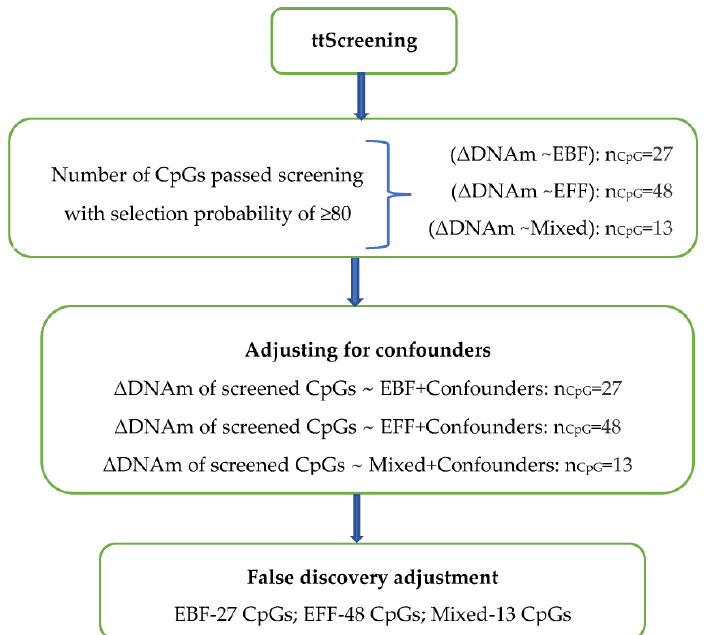
Figure 2. Number of CpGs associated with each infant feeding variable at each stage of analysis. ttScreening—training-testing screening method, ΔDNAm—delta DNA methylation (calculated using M-values) that represents change in DNA methylation from birth to 10 years after adjusting for the cell-type proportions and season of blood collections at both time points, EBF—exclusively breastfed for at least 13 weeks, EFF—exclusively formula-fed for at least 13 weeks, Mixed—a mixture of breastmilk with formula or solids before 13 weeks. nCpG indicates the number of CpGs that are significant with a p -value of <0.05. Table 2. List of CpGs significantly associated with the different modes of infant feeding. Feeding Variable